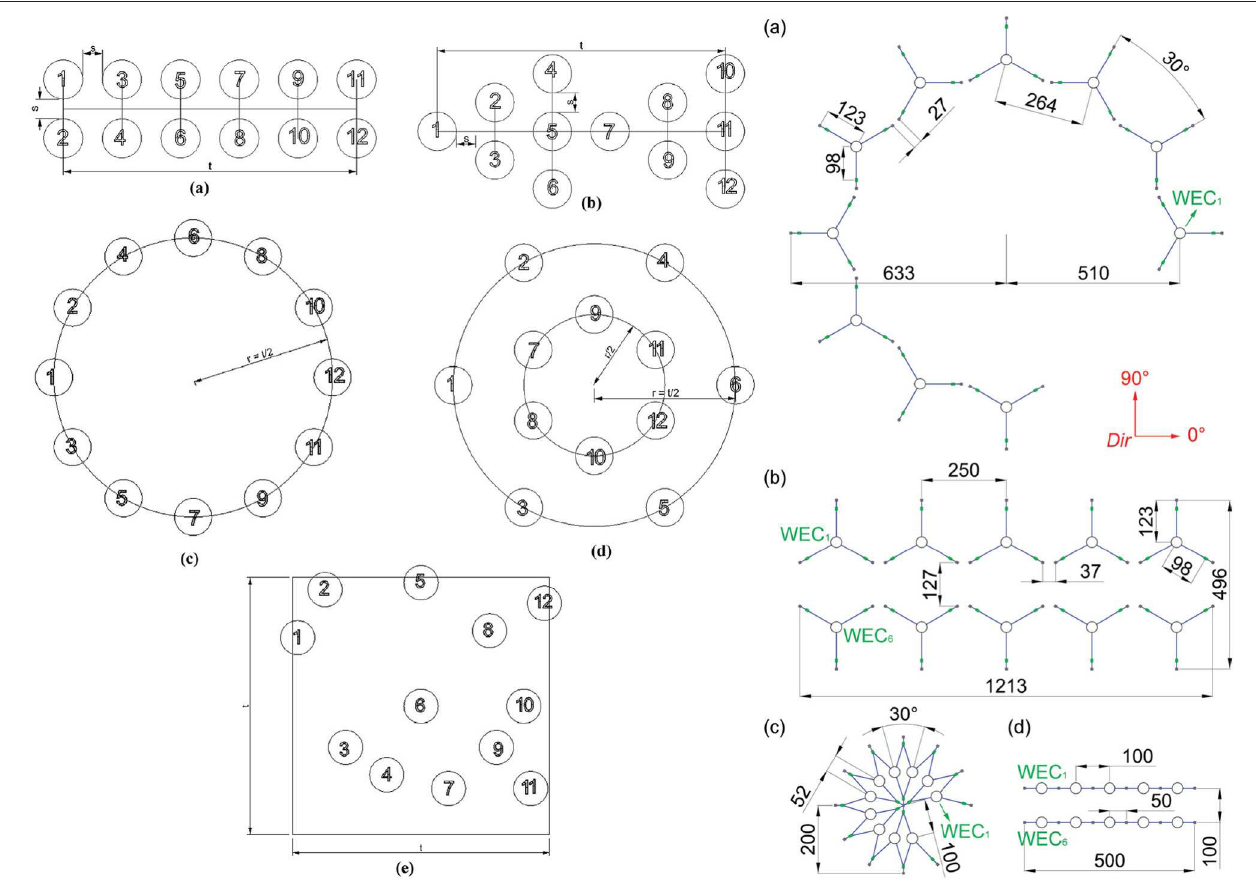
FIGURE 4 | (Left) Array layouts of cone-cylinder floats studied by Sinha et al. (2016) using WAMIT. (Right) Array layouts of 10 WaveEL devices compared by Yang et al. (2019) for performance and mooring